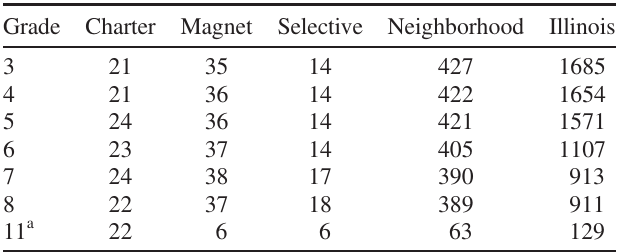
TABLE III. Number of schools represented by each point of Fig. 4(b).